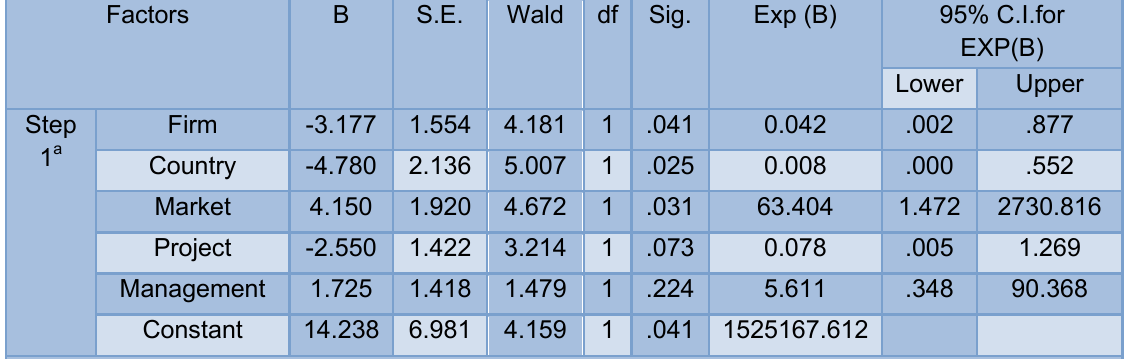
Variables in the Equation for EL Decision